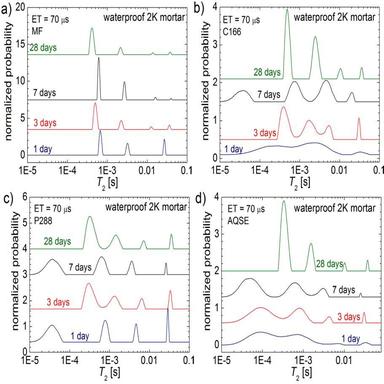
The normalized T2 distribution measured for a) MF, b) C166, c) P288 and d) AQSE at 1, 3, 7 and 28 days after preparation for samples of waterproof 2 K mortars.